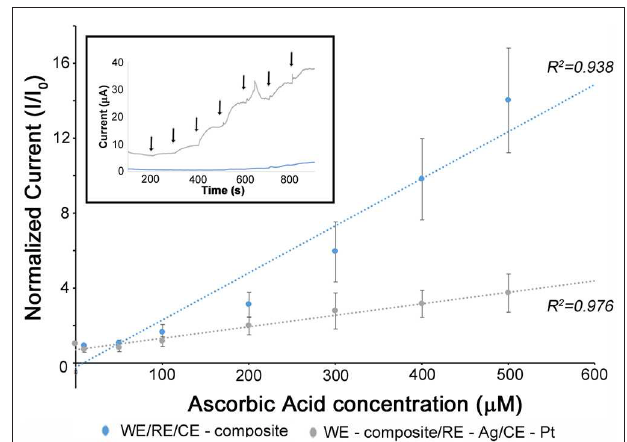
FIGURE 3 | The detection of ascorbic acid using different electrode combinations. The blue represents the electrochemical biosensor using sericin/PEDOT:PSS organic electrodes as Working Electrode (WE), Reference Electrode (RE), and Counter Electrode (CE) (O3E). The gray represents the electrochemical cell setup using sericin/PEDOT:PSS organic electrode as WE, Ag/AgCl electrode as RE, Pt as CE (OE). The inset figure is the calibration curve (normalized current vs. concentration of ascorbic acid) for the detection of ascorbic acid using the two electrical setups. The control sample was PBS ( I nor = 1). The addition of AA occurred at 100s intervals. In all experiments, at least three different sensors were